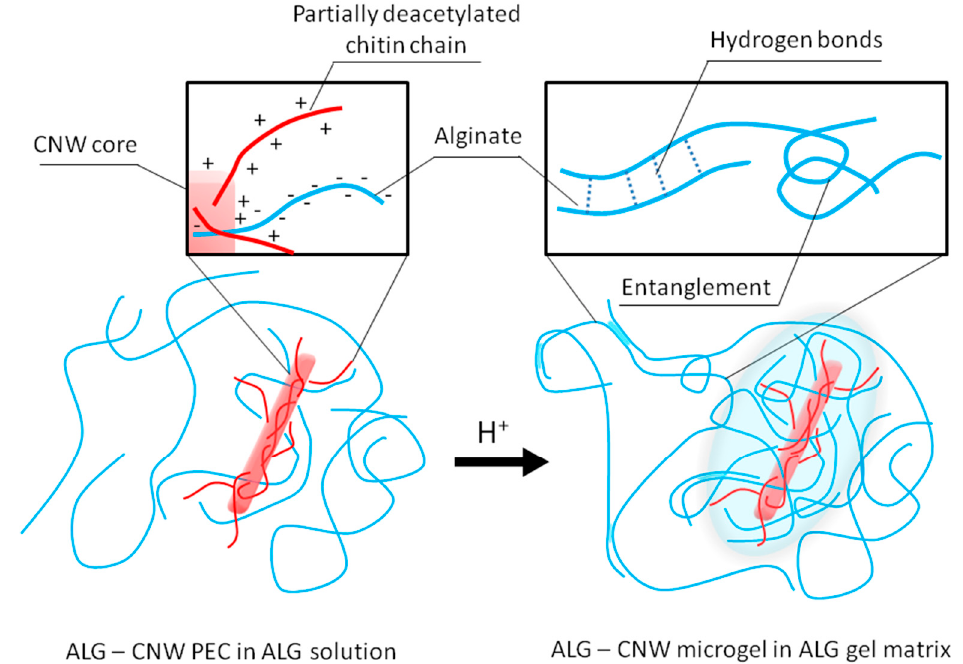
Figure 1. Scheme of the formation of alginate (ALG) hydrogel containing partially deacetylated chitin nanowhiskers (CNW).